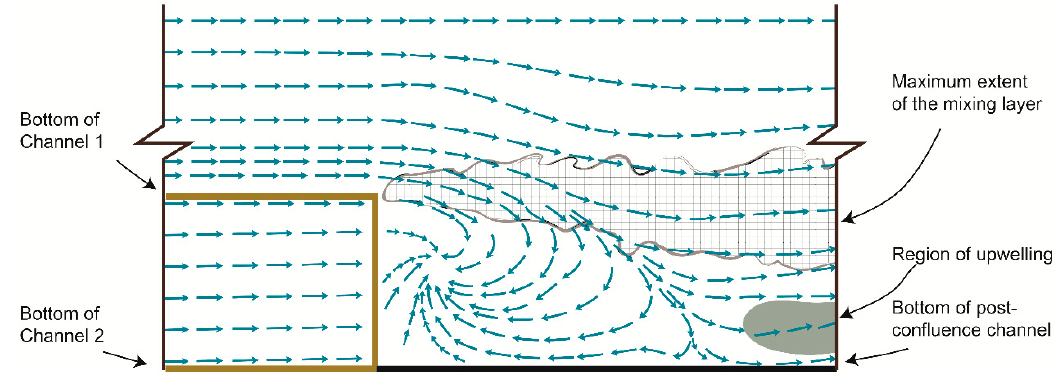
Figure 10. Flow fields at the bed of a discordant river confluence (Adapted from Best and Roy [34] ).